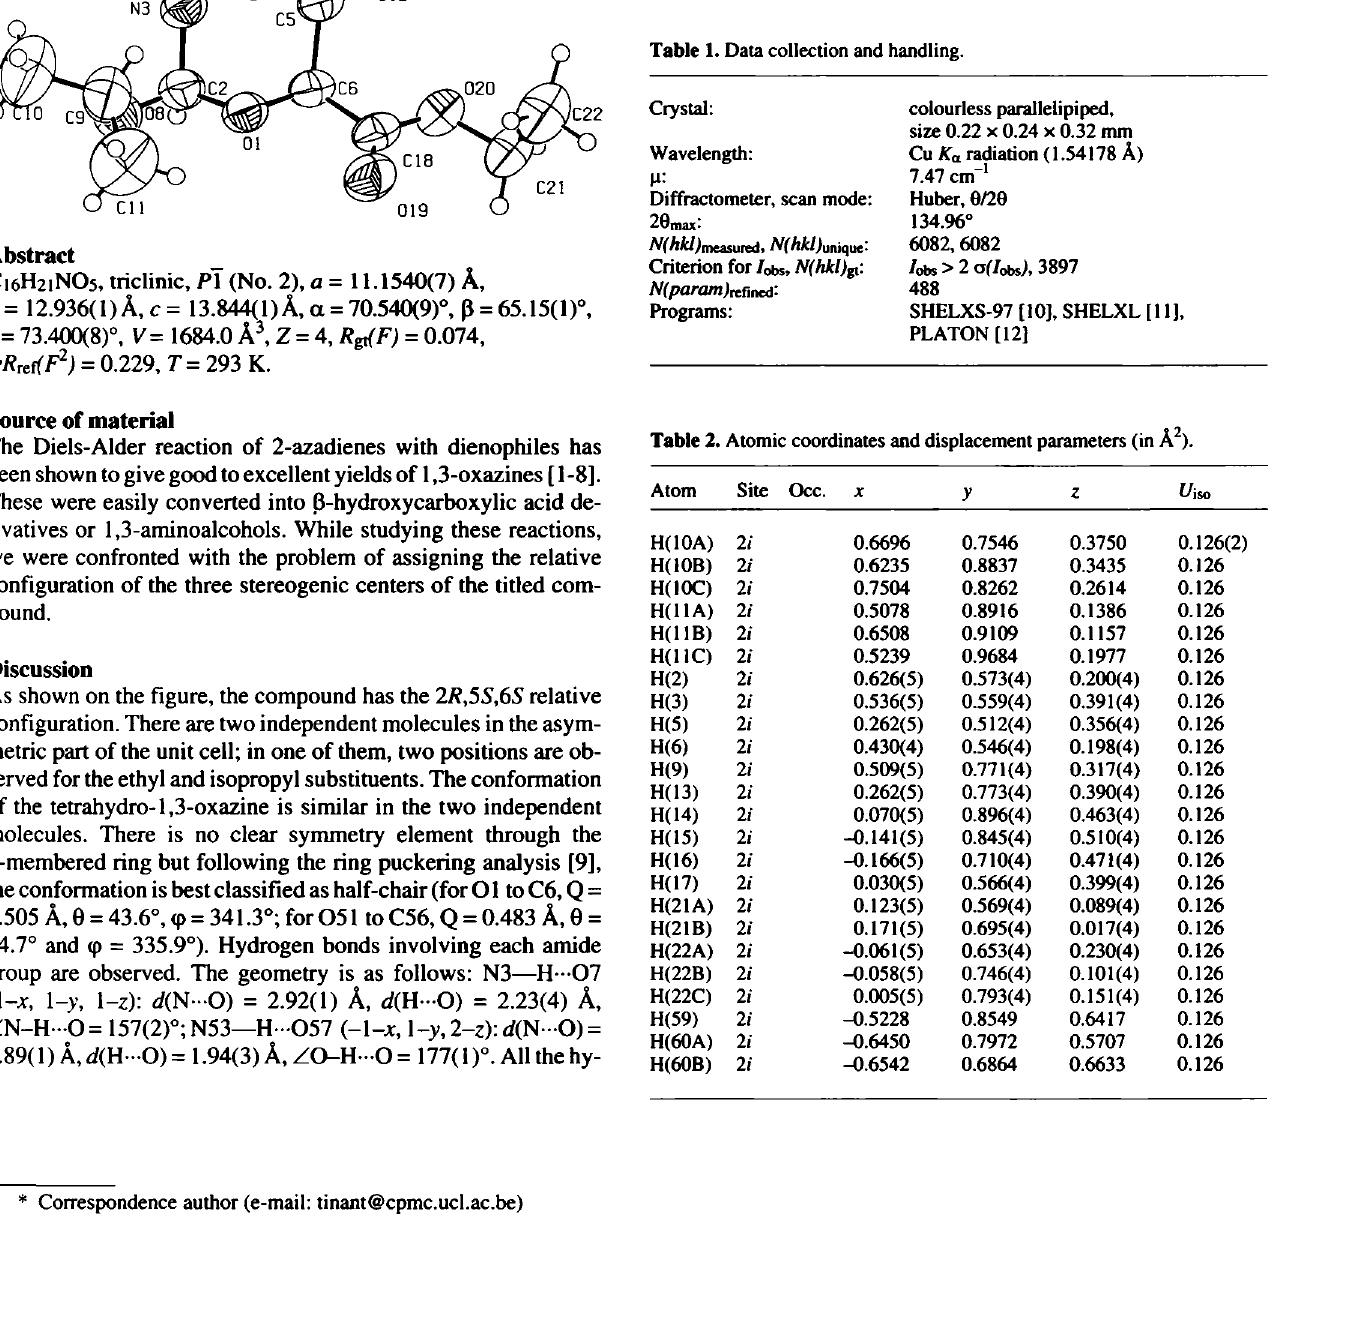
Table 1. Data collection and handling.